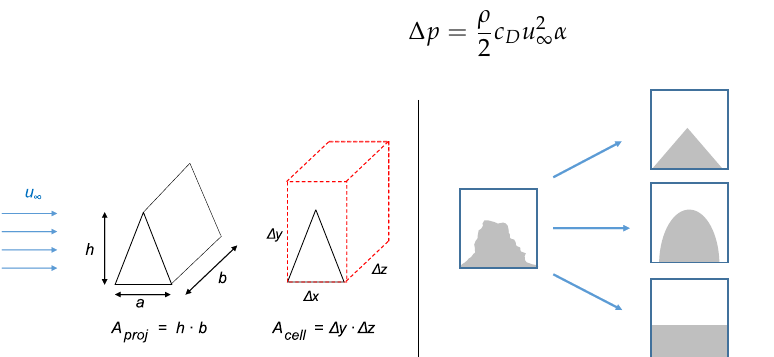
Figure 8. Explanations of the DPM procedure: ( left ) exemplary calculation of the projected area A proj for a regular roughness element in a porous cell; ( right ) approximation of an irregular surface roughness in a cell to a regular body